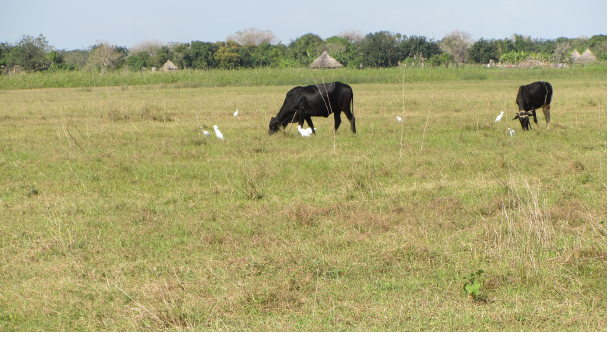
Fig. 2. Cattle grazing in a pastoral area.